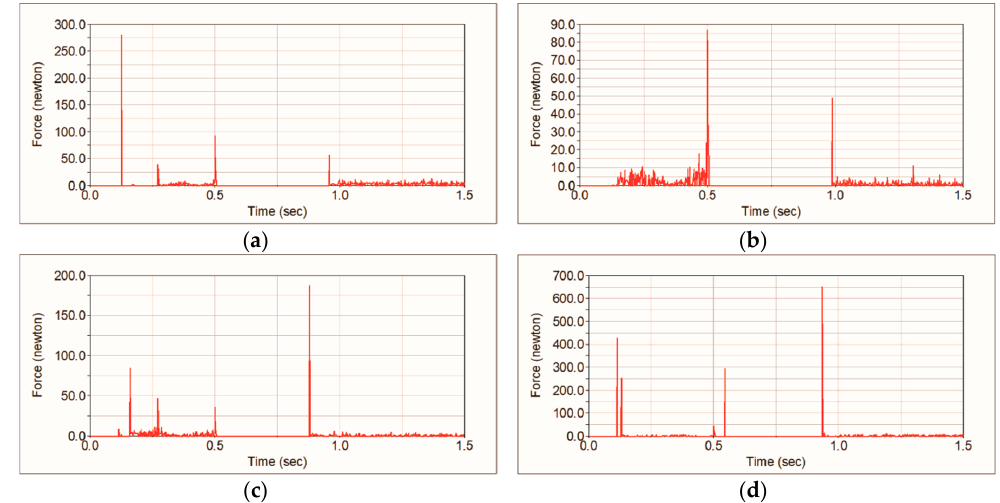
Figure 9. The contact forces between the ground and legs. ( a ) The contact force of the left front leg; ( b ) The contact force of the right front leg; ( c ) The contact force of the left hind leg; ( d ) The contact force of the right hind leg.